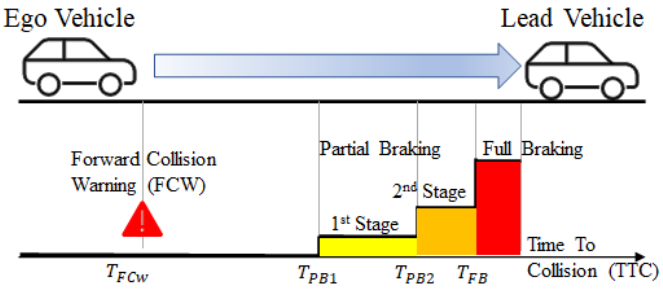
Figure 6. Autonomous emergency braking model